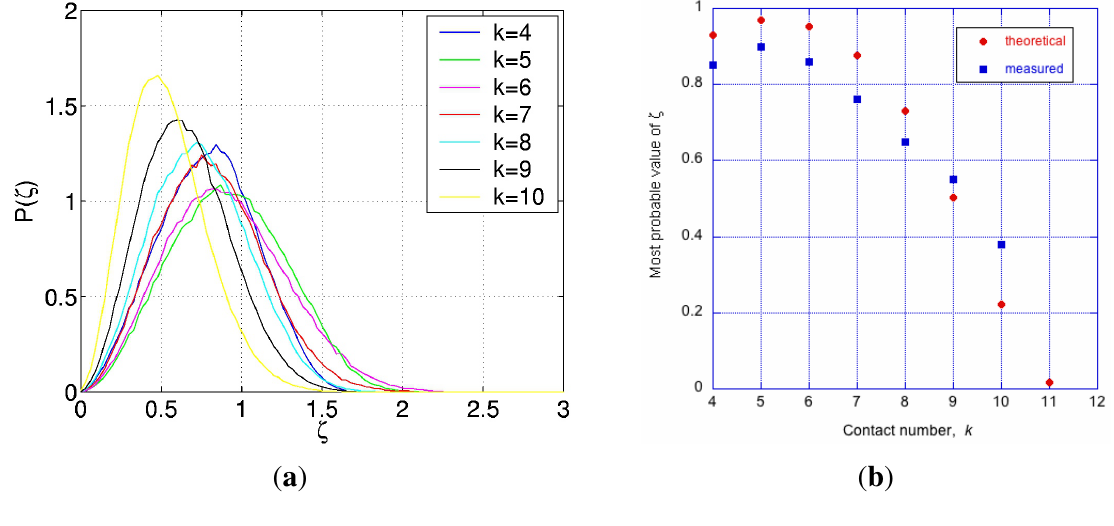
Figure 15. On left, probability functions for the random variable, ζ , for clusters with the values of k as shown. On right, the most probable value of ζ = ˆ ζ as a function of coordination number, k , predicted from Equation (11), and measured from simulations